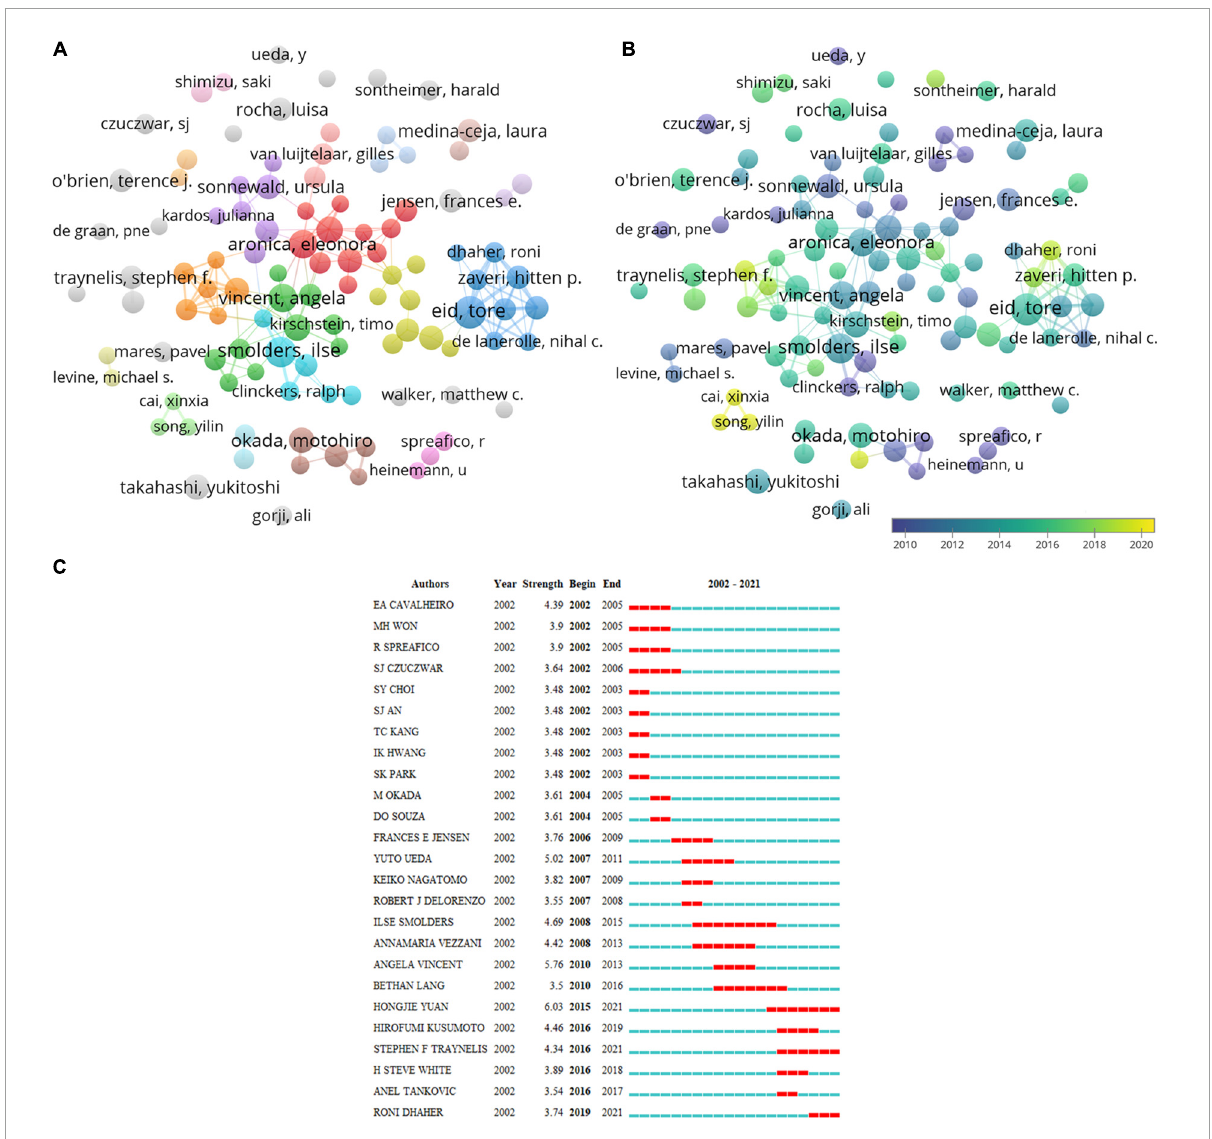
FIGURE5 Visualization of author analysis. (A) Co-occurrence of authors. (B) Visualization of countries based on APY. (C) Top 25 authors with the most vigorous citation